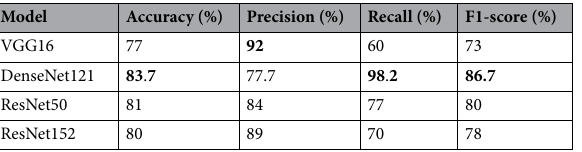
Table 4. Results of CNN models without Fast.AI. Bold is used to show the maximum achieved for each parameter.